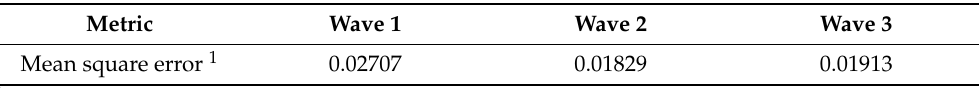
Table 3. Predictive performance achieved by the proposed ML pipeline for each of the three waves. Metric Wave